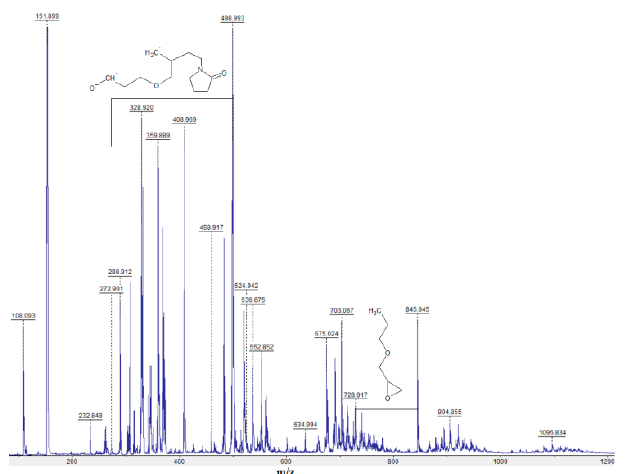
Figure 3. MALDI spectrum of an amphiphilic copolymer of N -vinyl-2-pyrrolidone and allyl glycyl ether obtained under anion detection conditions.